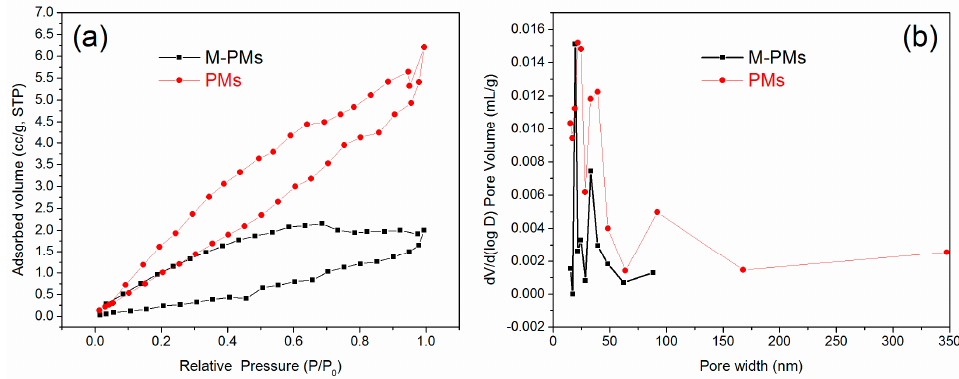
Figure 3. ( a , b ) Nitrogen adsorption-desorption isotherms ( a ) and pore size distribution ( b ) of M-PMs and PMs. The corresponding pore size distribution was determined by analyzing the desorption branch using the Barrett–Joyner–Halenda BJH method.